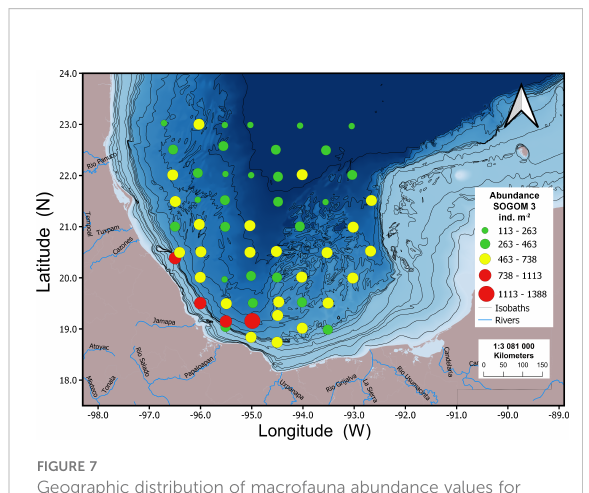
FIGURE 7 Geographic distribution of macrofauna abundance values for SOGOM 3.